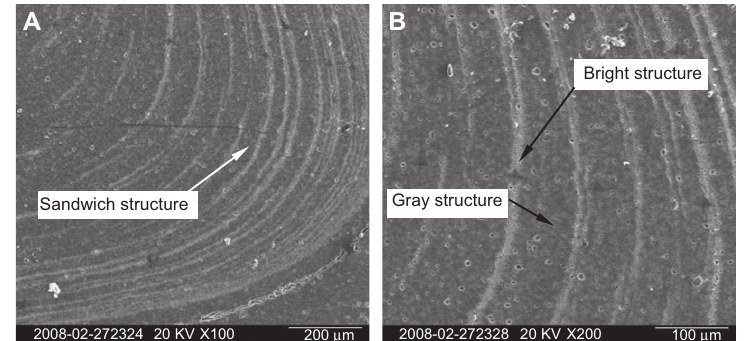
Figure 2 SEM micrographs of surface composite. (A) Sandwich structure of surface composite. (B) Fine characteristic of sandwich